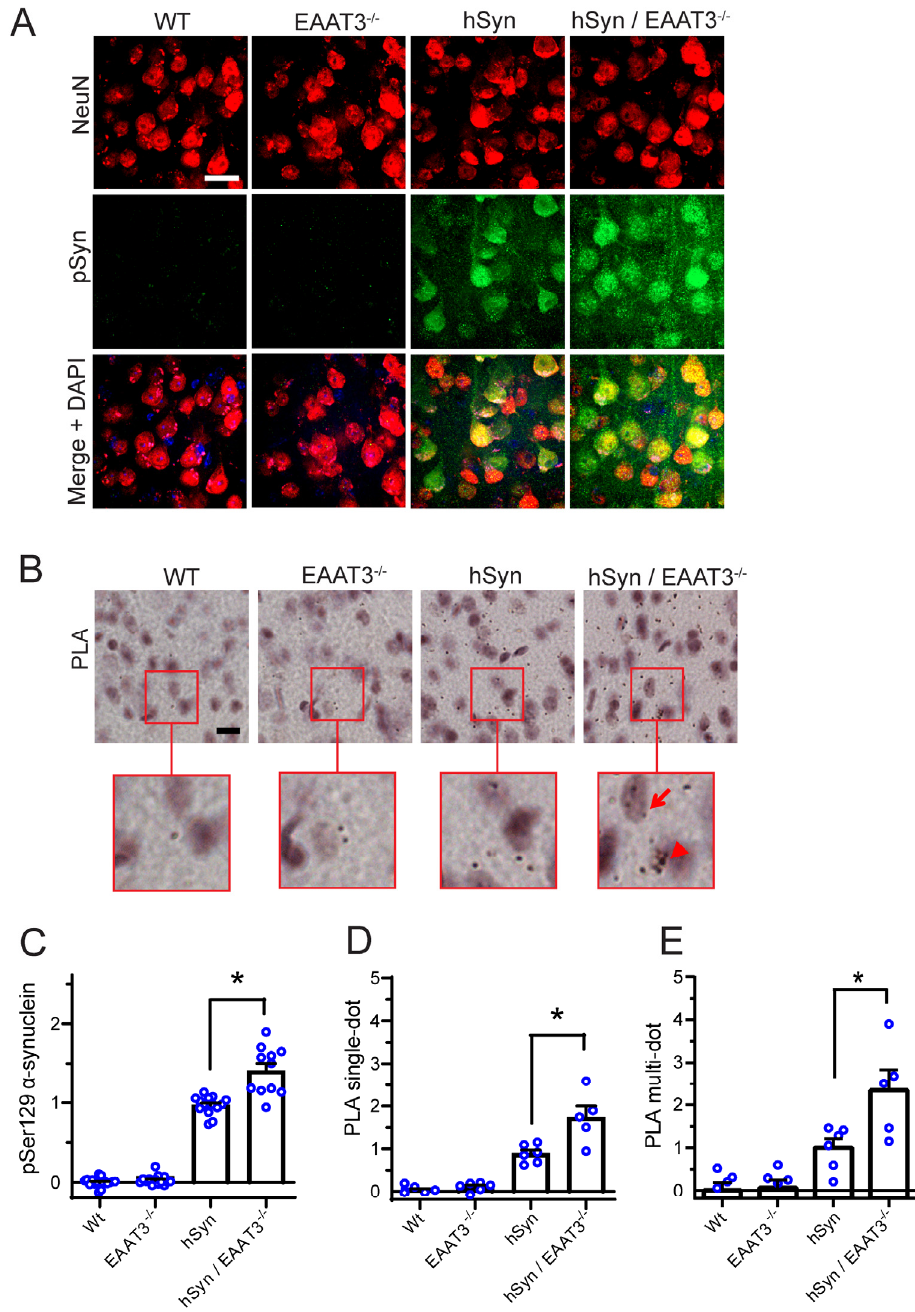
Figure 2. Increased α -synuclein aggregation in cortical neurons of hSyn/EAAT3 − / − mice. ( A ) Immunostaining for phosphoserine-129 α -synuclein (pSyn; green), with neuronal nuclei identi- fied by NeuN (red). Nuclei of all cells are counterstained with DAPI (blue) in the merged images. ( B ) α -synuclein aggregates are identified by proximity ligation assay (PLA). Red squares demark areas shown in magnified view. Examples of single dots are shown with arrows, and multiple dots are shown with arrowheads. All scale bars = 20 µ m. ( C ) Quantification of pSyn immunostaining. * p < 0.05, n = 8–11. ( D ) Quantification of single-puncta PLA signals; * p < 0.05, n = 5–7. ( E ) Quantifica- tion of multi-puncta PLA signals. For all quantifications, data from each mouse are expressed relative to signal measured in hSyn mice sections prepared and analyzed in